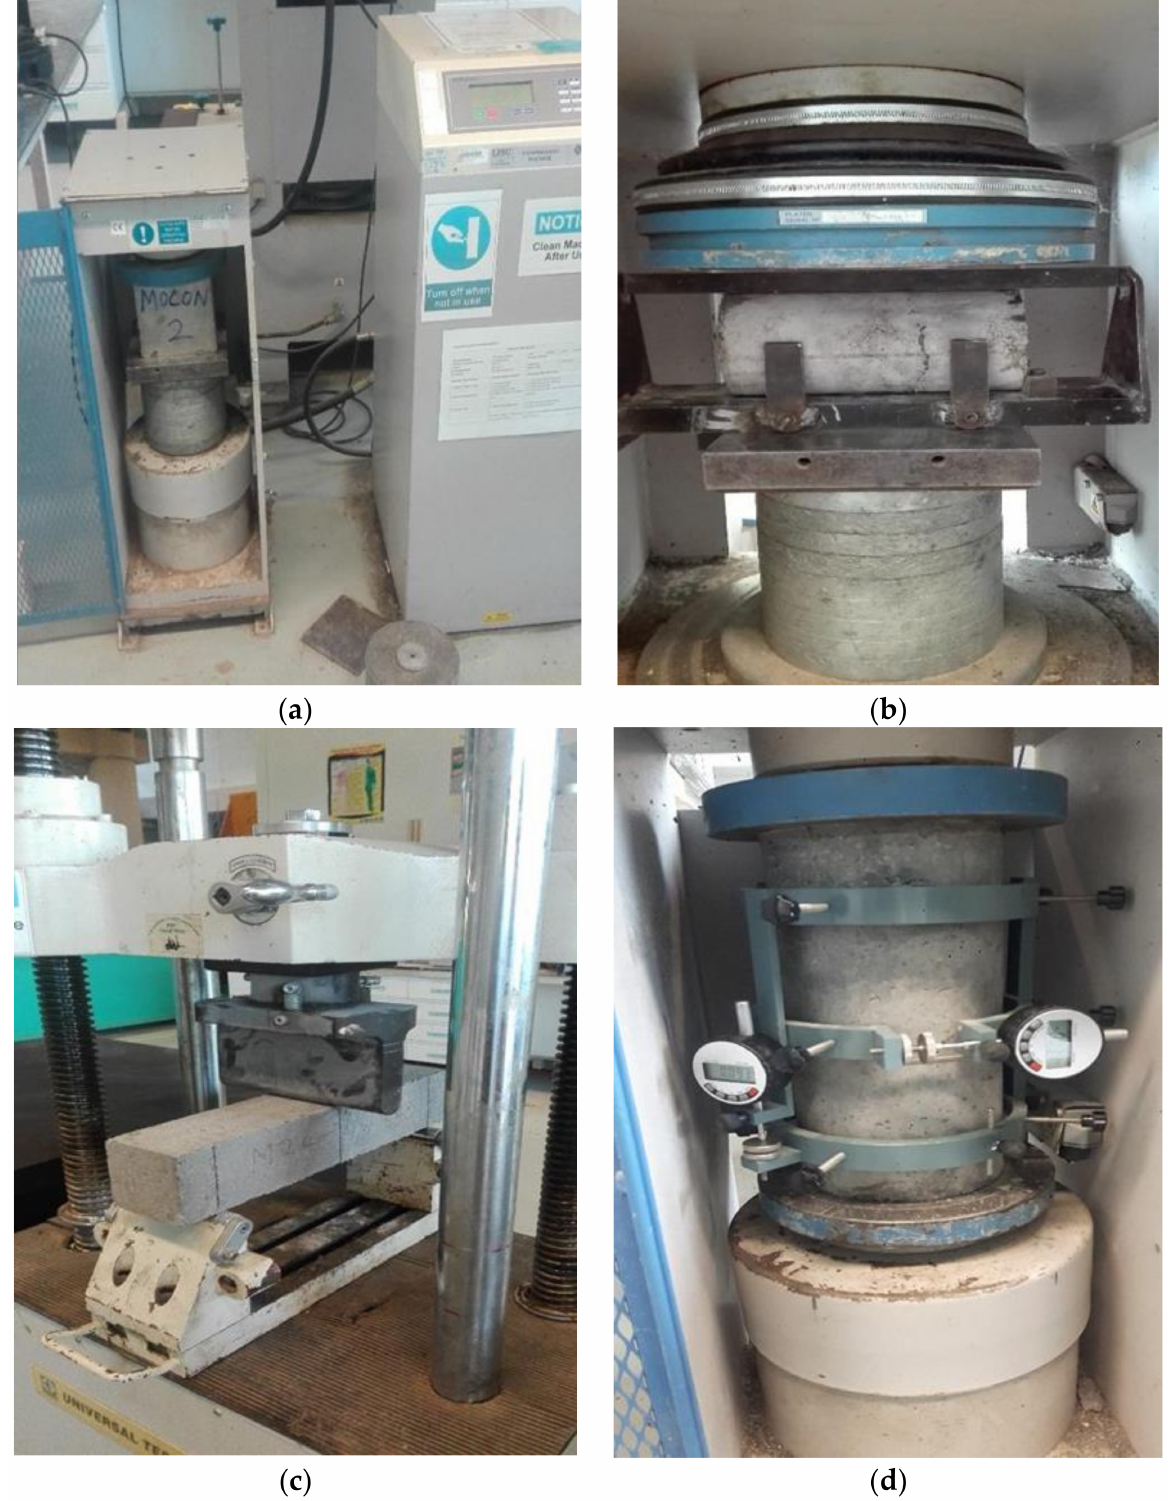
Figure 4. Experimental Setup. ( a ) Compressive Strength. ( b ) Splitting Tensile Strength. ( c ) Flexural Strength. ( d ) Modulus of